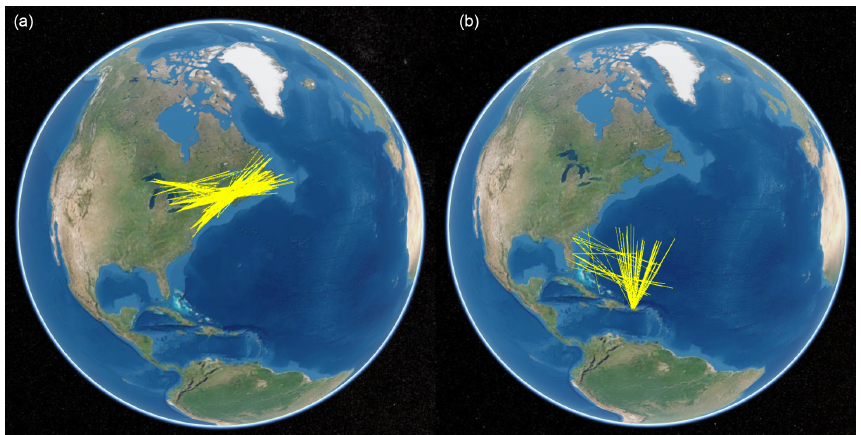
Figure 3. Figure 3 shows the long-distance AIS links identified by USCG stations (a) between 18:45–19:00UT on 14 July 2021 and (b) be- tween 14:15–14:30UT on 13 July